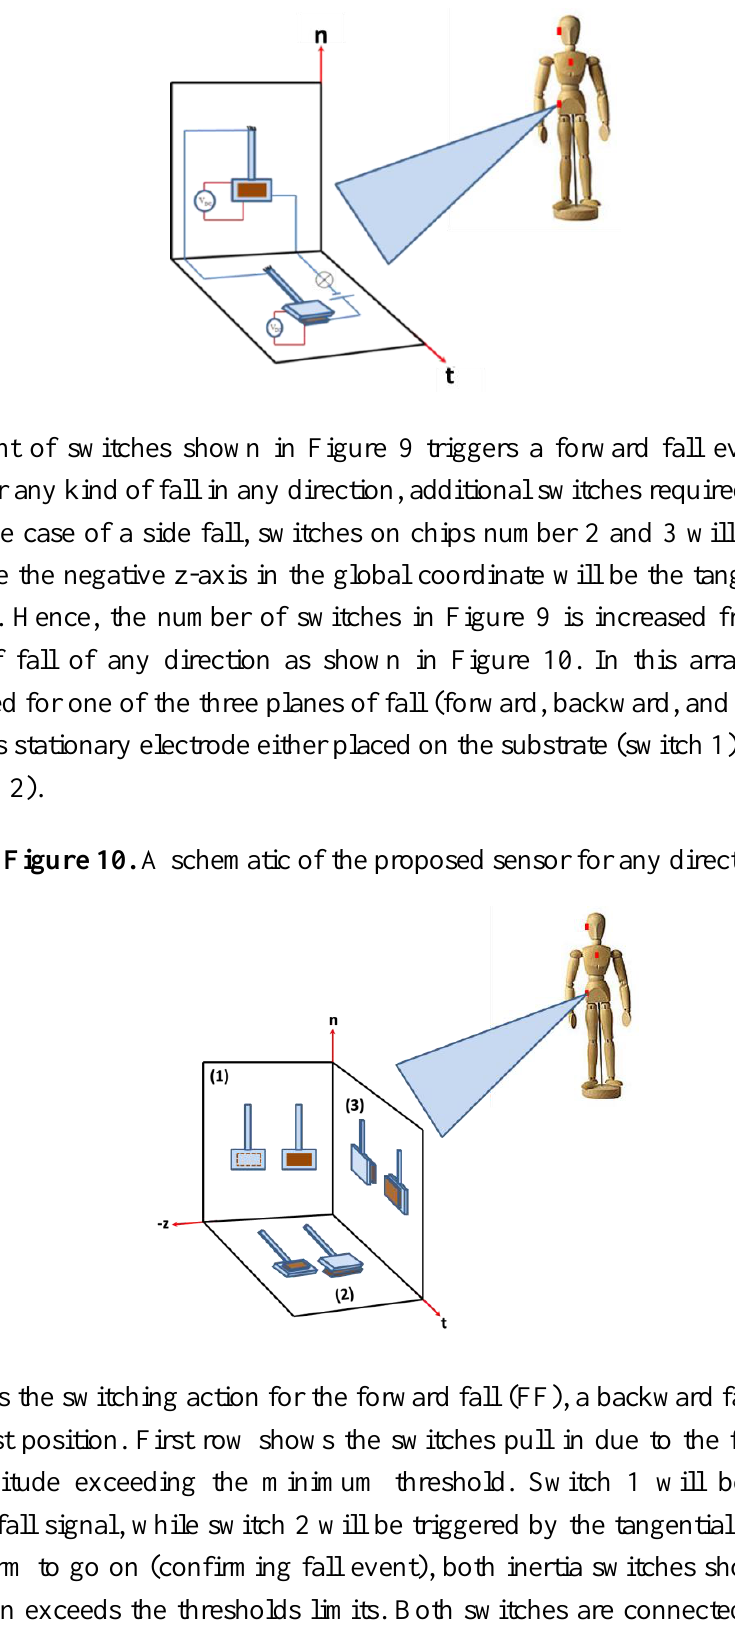
Figure 9. A schematic of the proposed sensor in FF or BF.